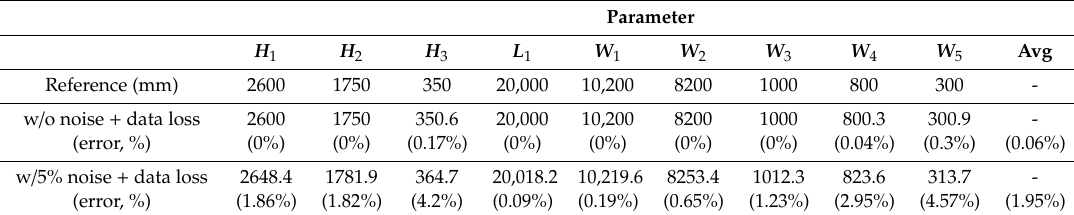
Figure 18. Point cloud data used for the BIM-model validation test ( a ) w / o noise + data loss ( b ) w / 5% noise + data loss. Table 1. Predicted parameters for BIM-model validation